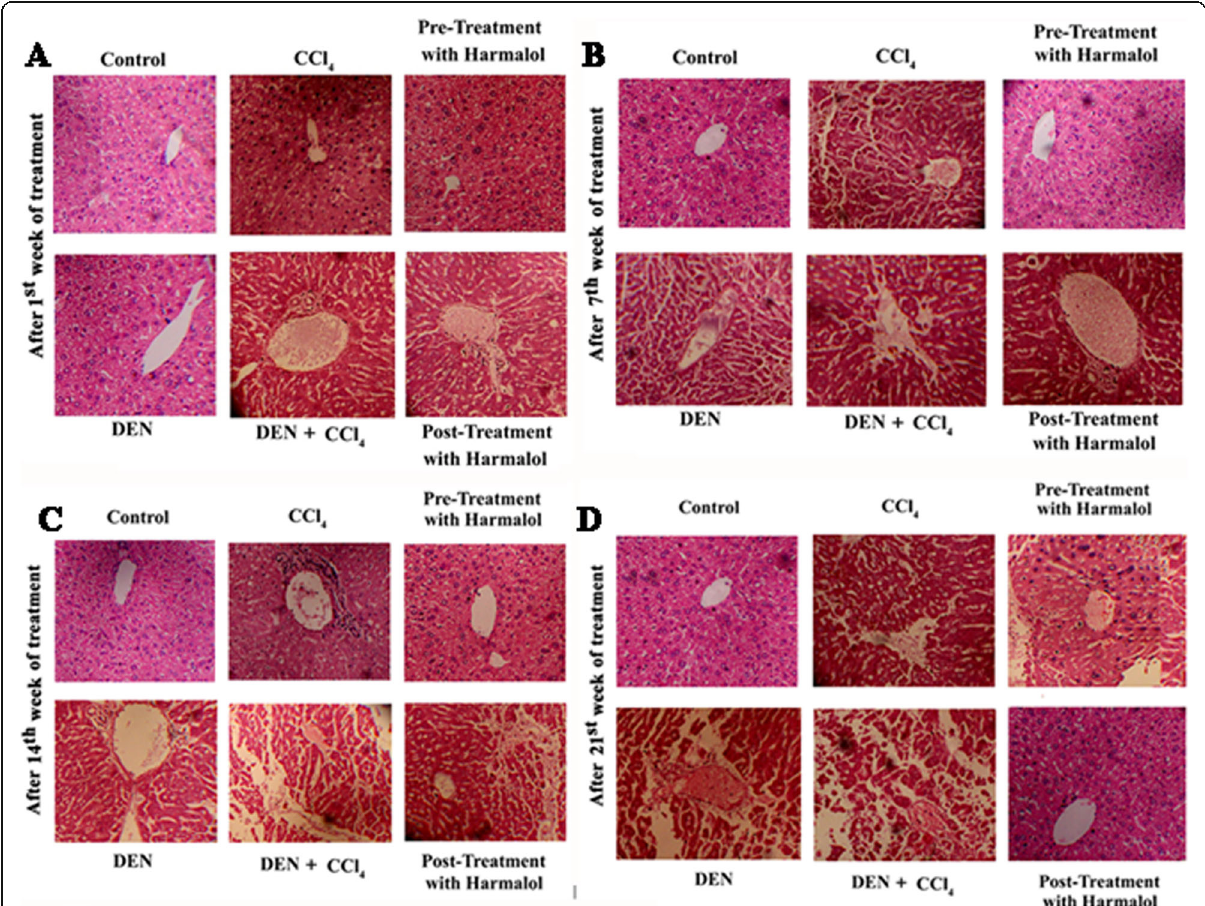
Fig. 7 Histological studies of the liver tissues obtained from the control, carcinogen, and harmalol pre- and post-treated groups. a After the 1st week, b after the 7th week, c after the 14th week and d after the 21st